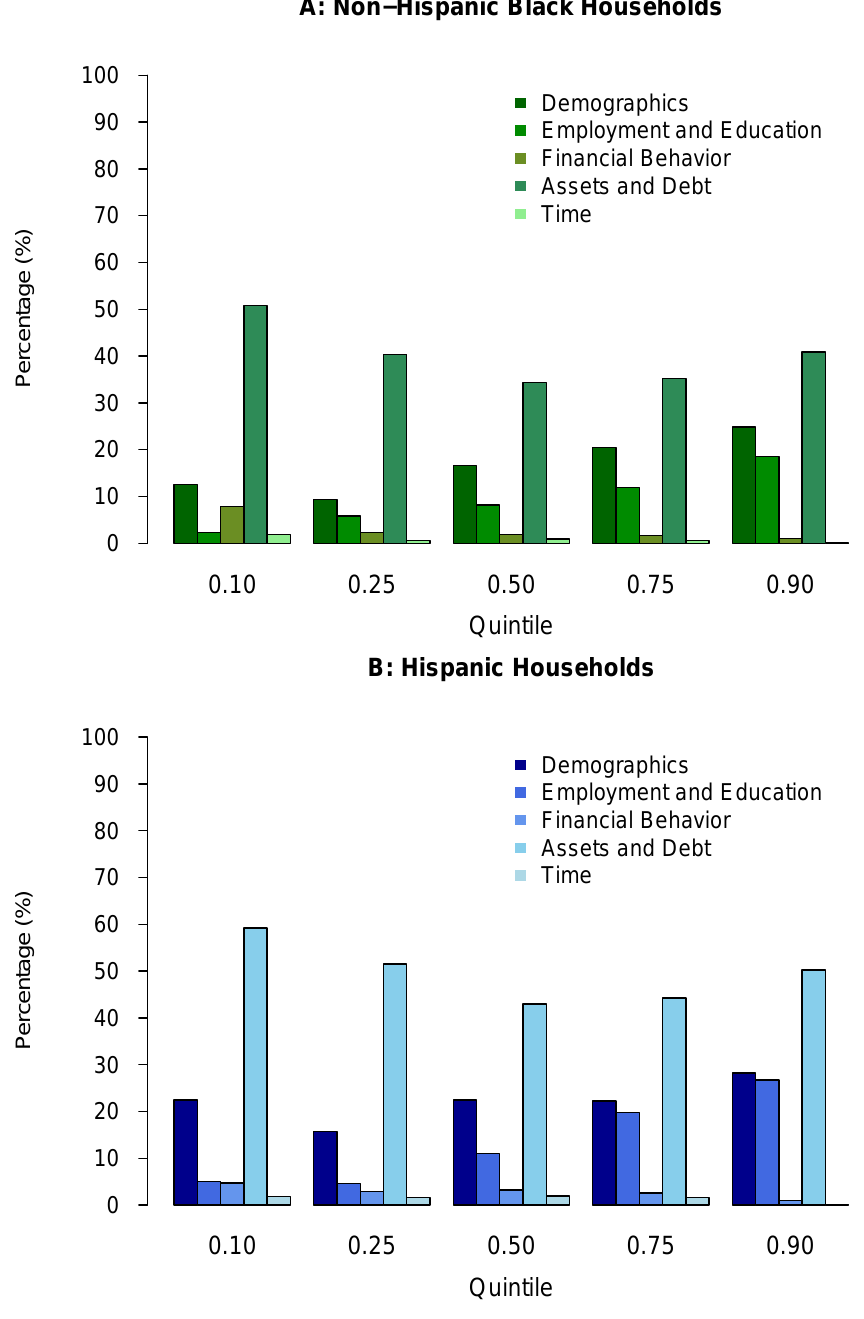
Figure 4: Percentage of explained net worth gap attributable to different factors by quintile,